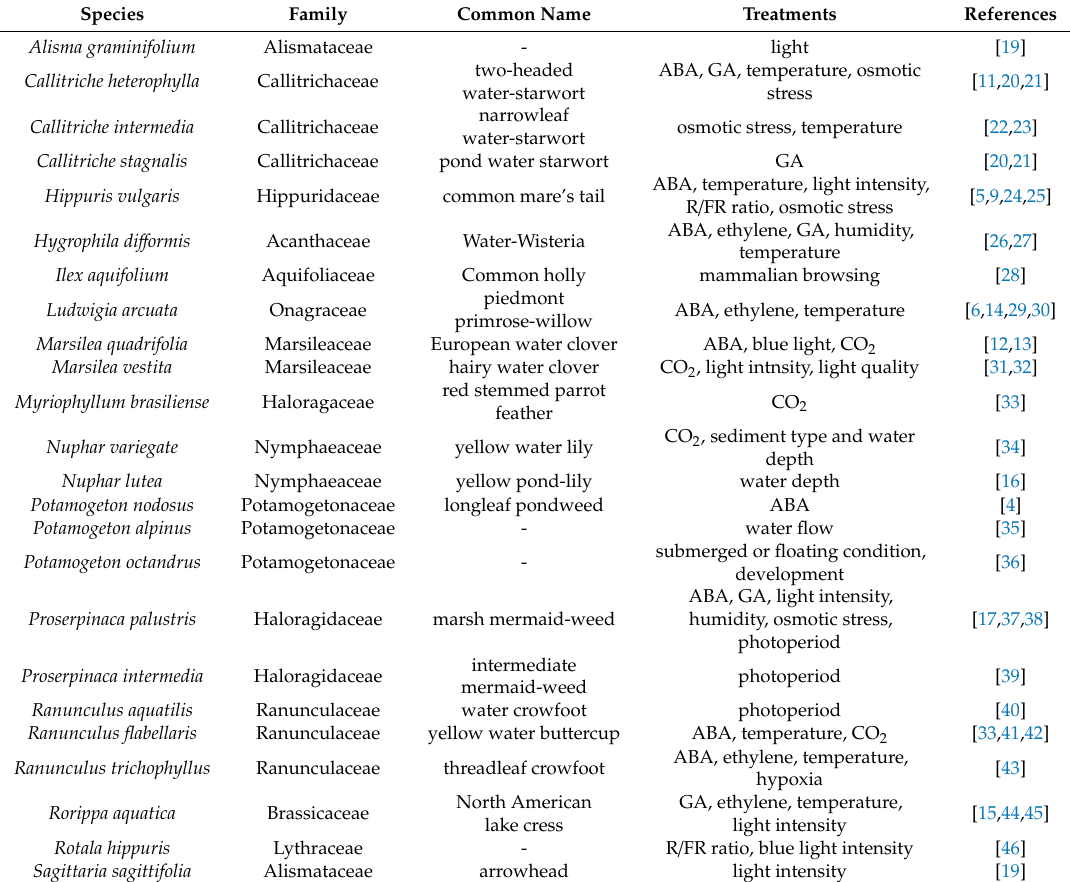
Table 1. Representative heterophyllous plants and treatments that can induce heterophylly.